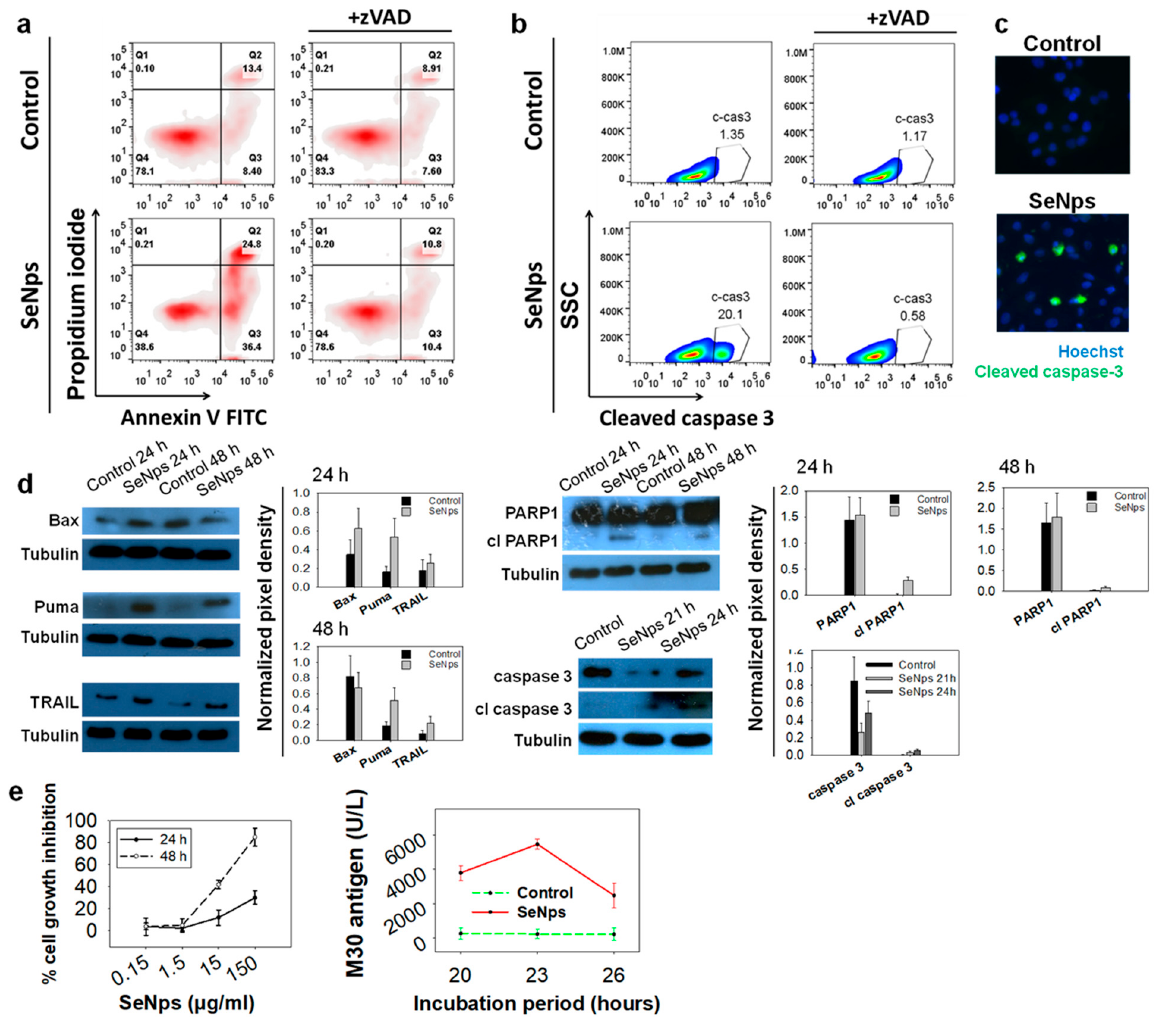
Figure 2. SeNps induce apoptosis in human colon cancer cells. ( a ) SeNps induce apoptotic cell death in HT29 cells which was reversed by the pan-caspase inhibitor zVAD-FMK. Flow cytometry density plots of control and treated cells. The percentages of viable (Annexin V-FITC and PI-negative), early apoptotic (Annexin V-positive and PI-negative), and late apoptotic/necrotic (Annexin V/PI-double-positive) cells are indicated on the plots. Cells were treated with 15 µ g/mL SeNps for 24 h and stained with Annexin V-FITC and PI before being analysed by flow cytometry. zVAD (20 µ M) was added in the culture medium 1 h prior to the addition of SeNps. ( b ) SeNps induced activation of caspase 3 in HT29 cells. SeNps-treated HT29 cells (15 µ g/mL, 24 h) were fixed, permeabilised and labelled with an anti-cleaved caspase 3 antibody prior to flow cytometry analysis. zVAD was added to the culture medium, where indicated, one (1) hour before the addition of SeNps. A 20.10% ratio of cells positive for cleaved caspase 3 was observed in SeNps-treated cells compared to 1.35% in control. zVAD prevented the activation of caspase 3 by SeNps which is evident by the 0.58% ratio of cleaved caspase 3-positive cells observed in SeNps-treated cells that were also incubated with the inhibitor. Results presented are representative of at least three independent experiments. ( c ) Caspase 3 activation confirmed by fluorescence microscopy. Cells seeded on glass coverslips were treated with 15 µ g/mL SeNps for 24 h, fixed, permeabilised and labelled with the same anti-cleaved caspase 3 antibody before being observed under a fluorescence microscope (magnification: 1000 × ). ( d ) Western blot analysis for the pro-apoptotic proteins Puma, Bax, TRAIL and the cleavage of PARP1 and caspase 3 in SeNps-treated (15 µ g/mL) HT29 cells for 24 or 48 h. Note the increase in Puma, TRAIL and cleaved PARP1 as well as caspase 3 in SeNps-treated compared to control cells, for either time points, and the increase of Bax in 24 h. Western blot images presented are representative of at least two independent experiments. ( e ) Growth inhibition and M30 levels in Caco-2 cells treated with SeNps. Cell growth inhibition was analysed by an SRB assay after 24 h or 48 h of treatment. M30 levels were quantified in cell extracts. Caco-2 cells were treated with 15 µ g/mL SeNps for 20–26 h. M30 levels were quantified in cell lysates with the M30 Apoptosense ELISA kit. Results in the graphs are presented as mean value ± S.D. of two independent